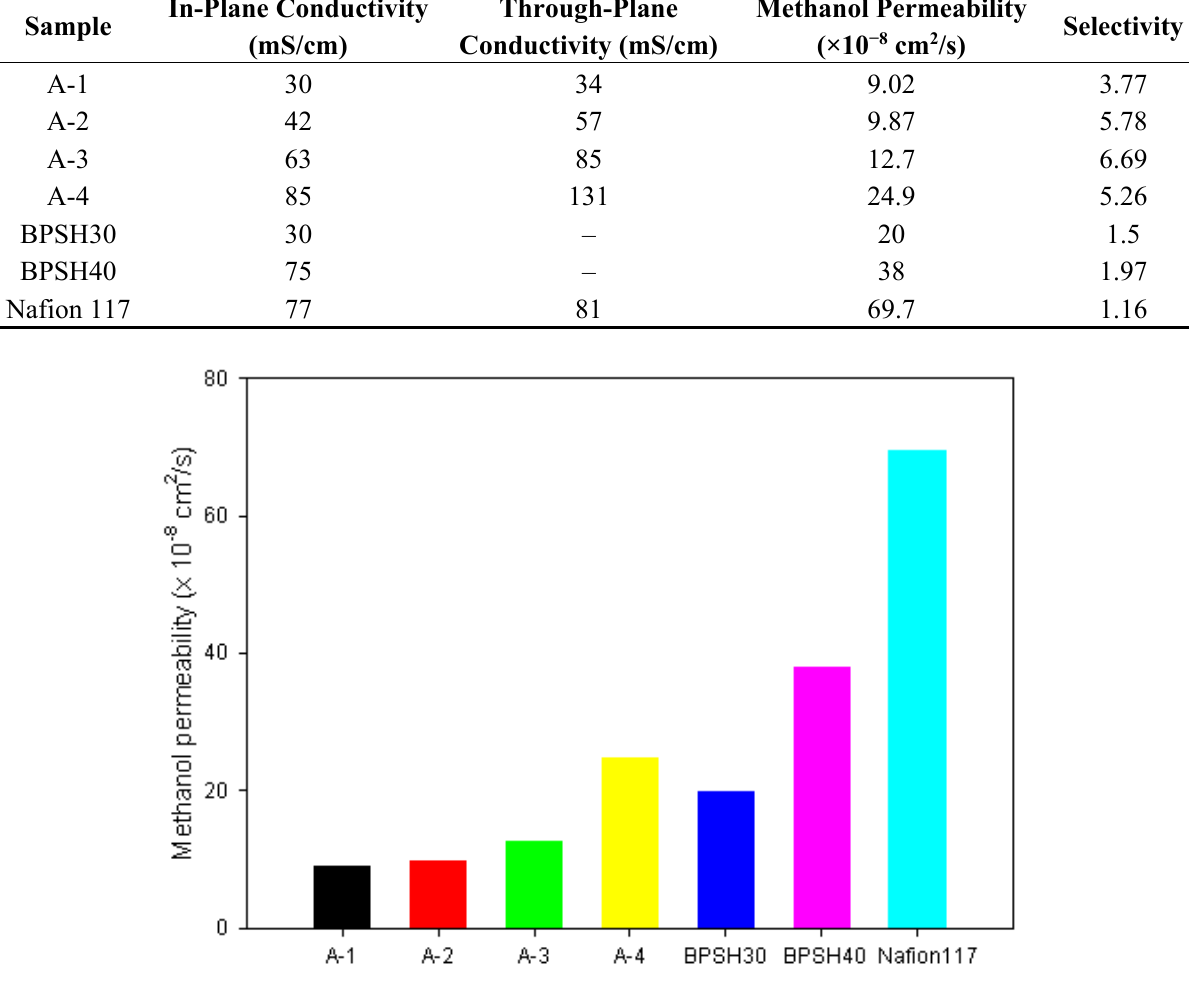
Figure 3. Methanol permeability of PE-g-s-PAES and reference PEMs for